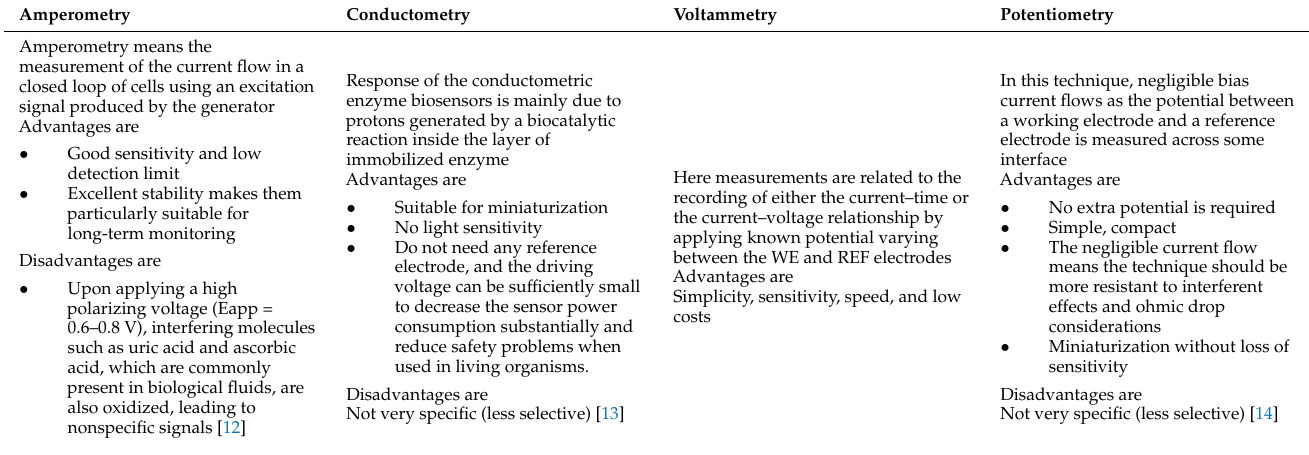
Table 2. Different types of electrochemical